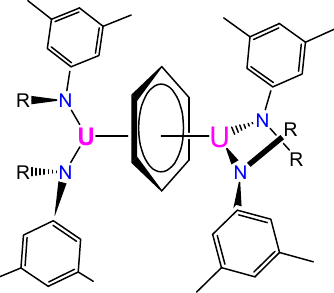
Figure 16. Structure of the ( µ -toluene)U 2 (N[ t Bu]Ar) 4 (Ar = 3,5-C 6 H 3 Me 2 ) complex [16].